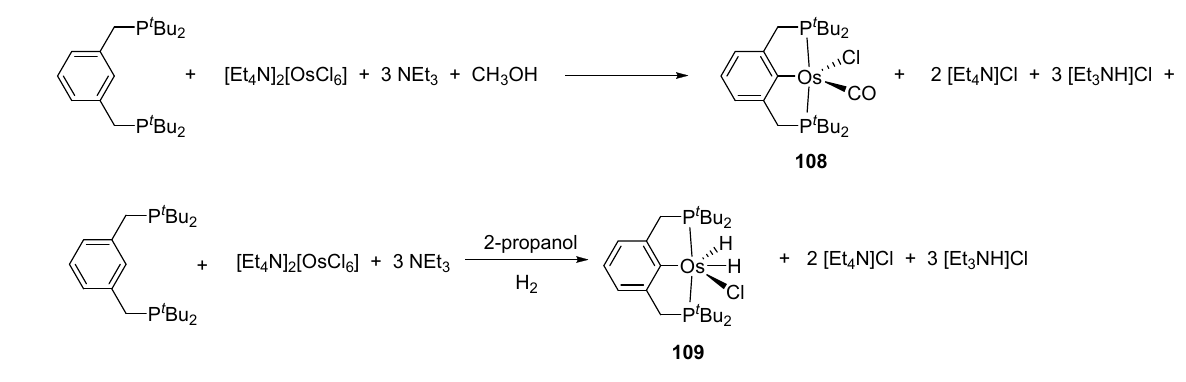
Figure 23. Synthesis of osmium P~C~P pincer using [Et 4 N] 2 [OsCl 6 ]. Complex [Et 4 N] 2 [OsCl 6 ] reacts also with 1,5- bis (di-terbutylphosphino)pentane in the